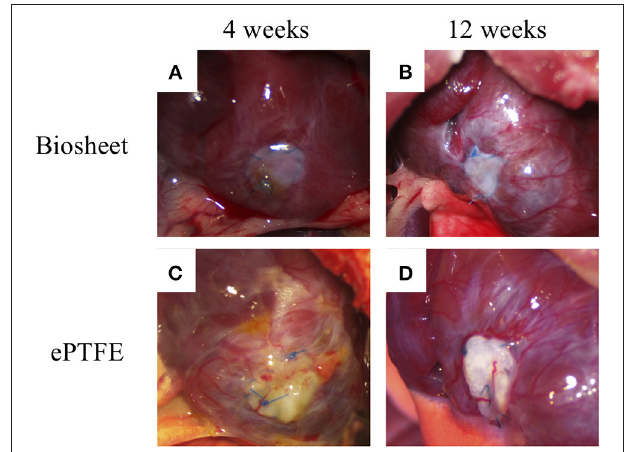
FIGURE 3 | Representative images of biosheets (A,B) and ePTFE (C,D) at cardiac explantation. Dense fibrous adhesions to the sternum on the epicardial surface were also observed in 7 of 9 rats with ePTFE grafts, whereas 2 of 9 rats with